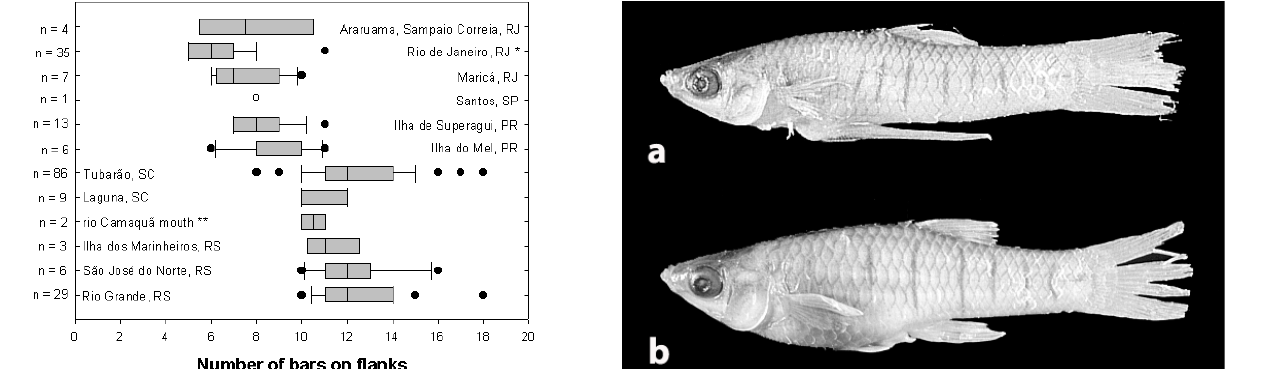
Fig. 7. Phalloptychus januarius . UMMZ 231550, Farol de São Tomé, Rio de Janeiro, Brazil. (a) male, 16.1 mm SL; (b) female, 21.9 mm